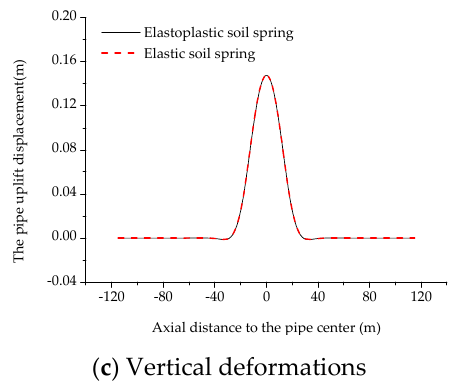
Figure 8. Results for a liquefaction zone length equal to 30 m.